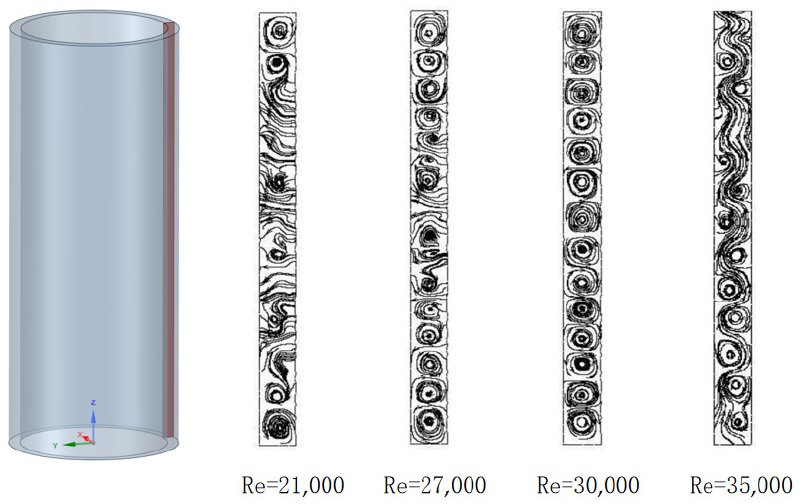
Figure 11. Annulus flow diagram of conventional Taylor reactor.